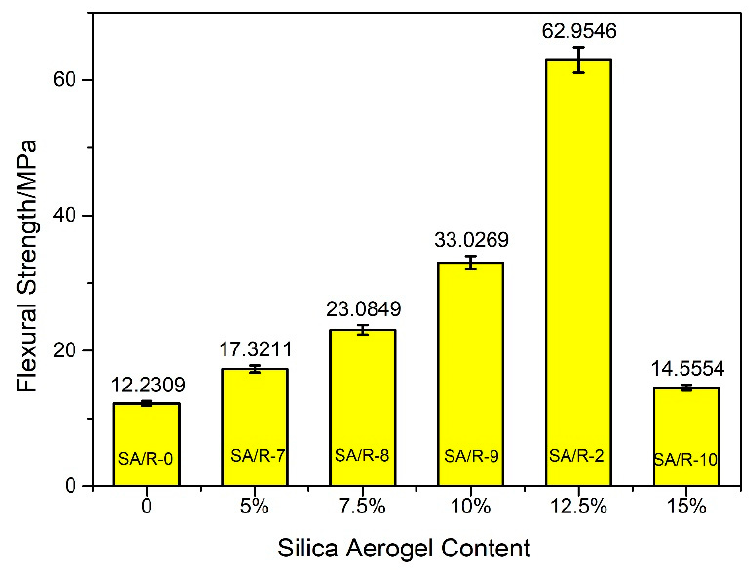
Figure 9. Effect of silica aerogel content on the flexural strength of the silica aerogel/resin